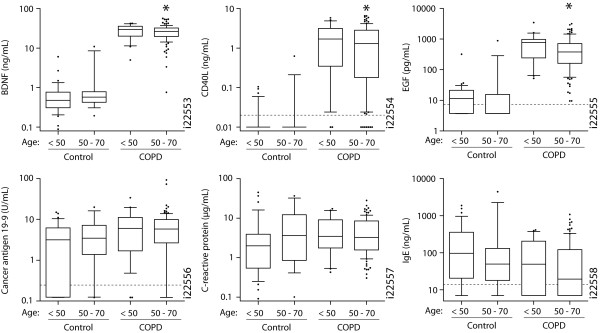
Baseline serum analyte concentrations in current smokers. The serum concentrations of the indicated analytes in healthy control and COPD cohorts, restricted to only current smokers, are shown for subgroups < 50 (n = 36 and 22 for controls and COPD, respectively) or between 50- to 70-years-old (n = 16 and 107 for controls and COPD, respectively). Data presented as box (median, interquartile range) and whiskers (10th-90th percentiles). Dotted line indicates LDD. *COPD vs control, False discovery rate < 10-8 within 50-70 year age group. BDNF, brain-derived neurotrophic factor; CD40L, CD40 ligand; EGF, epidermal growth factor; IgE, immunoglobulin E.